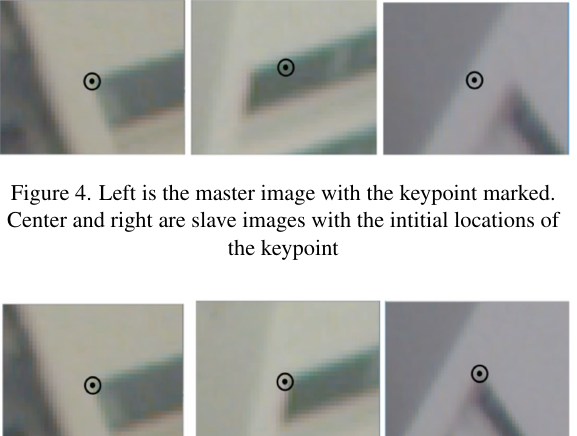
Figure 7. The four corners of a window are selected by the operator, then the window is represented by two polygons.